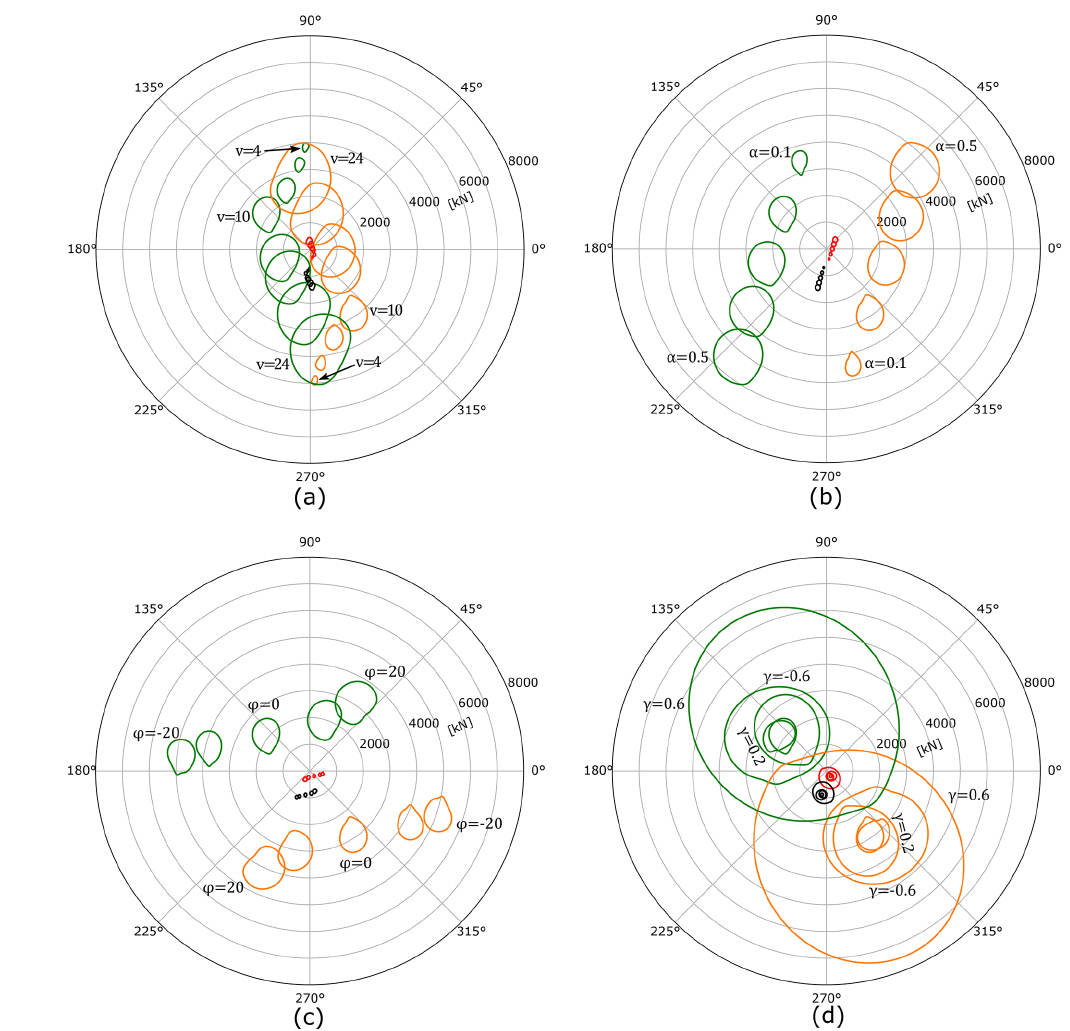
Figure 4. Bearing row radial force response patterns for the 5MW turbine under various values of reference-height wind speed ( v ), shear exponent ( α ), yaw offset ( ϕ ), and veer ( γ ) are shown in panels (a) – (d) , respectively. Overhung support results for upwind and downwind rows are orange and green, and centred support results for upwind and downwind rows are red and black, respectively. As described in the opening paragraph of Sect. 4, force results are aligned with the true direction of applied force when viewing the turbine from upwind. For example, an applied force acting vertically downwards corresponds to an angle of 270 ◦ in the above